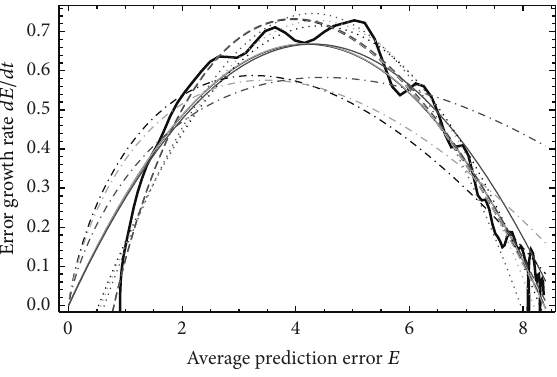
Figure 7: As Figure 5 for ND 5 , 𝑀 5 .